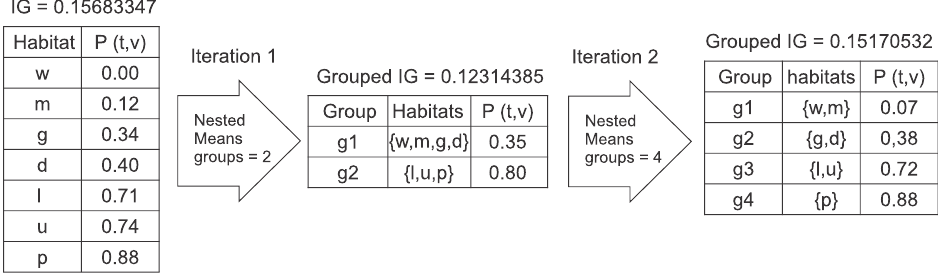
Figure 2. VCCA example.